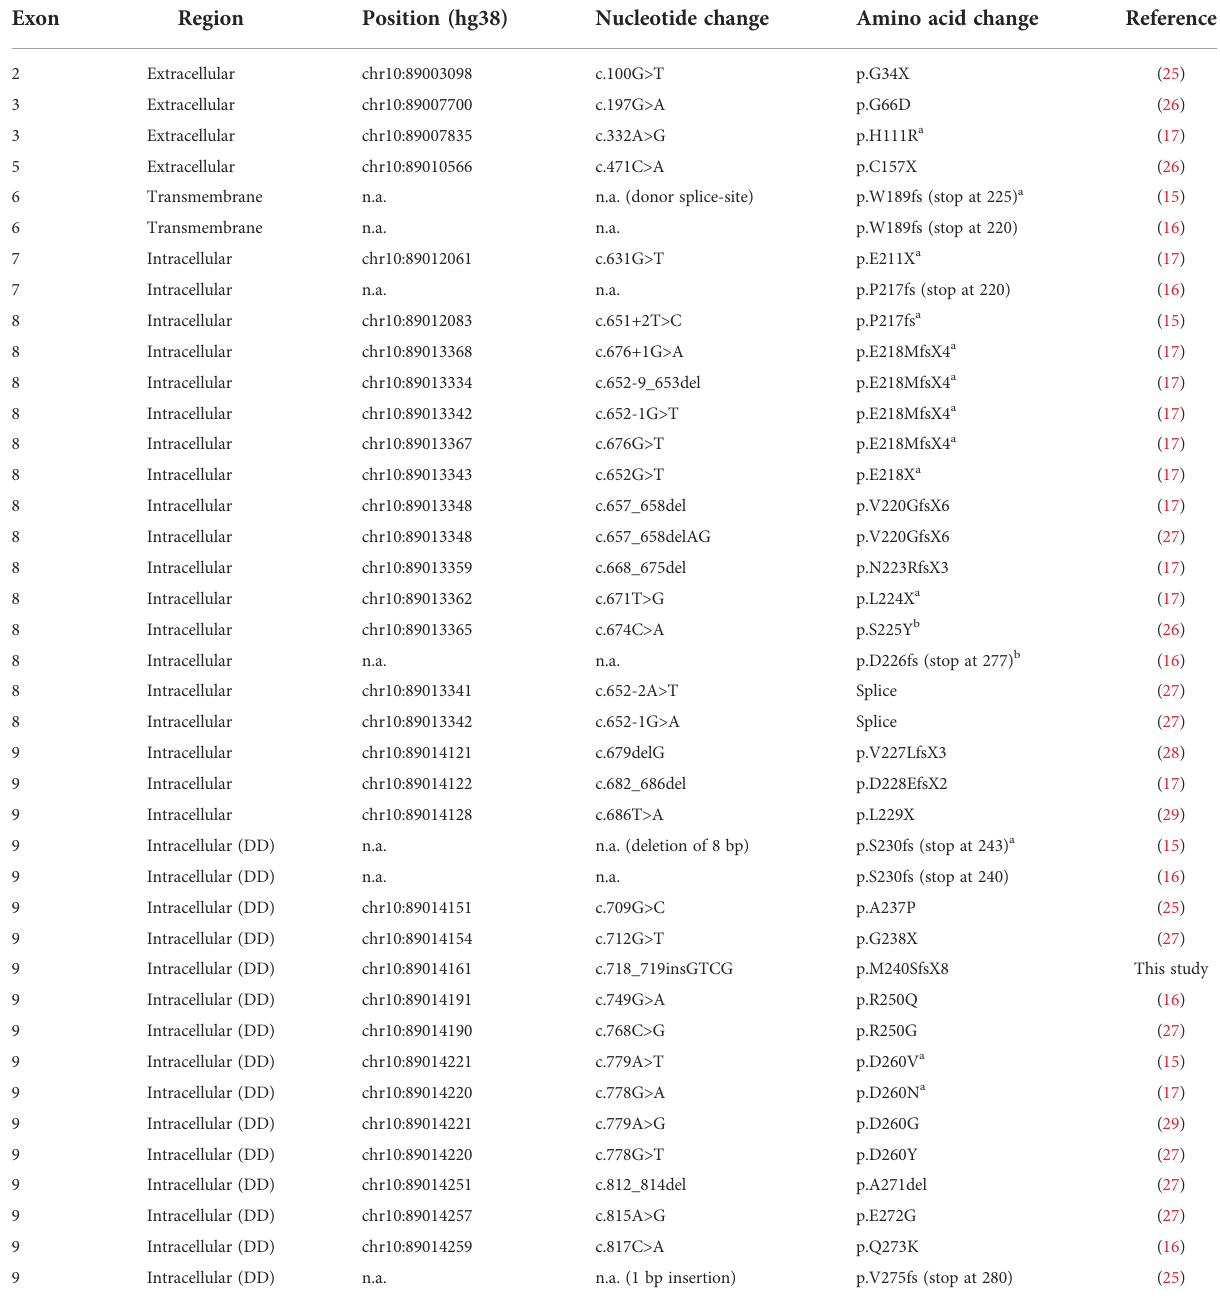
TABLE 2 Somatic FAS variants associated with